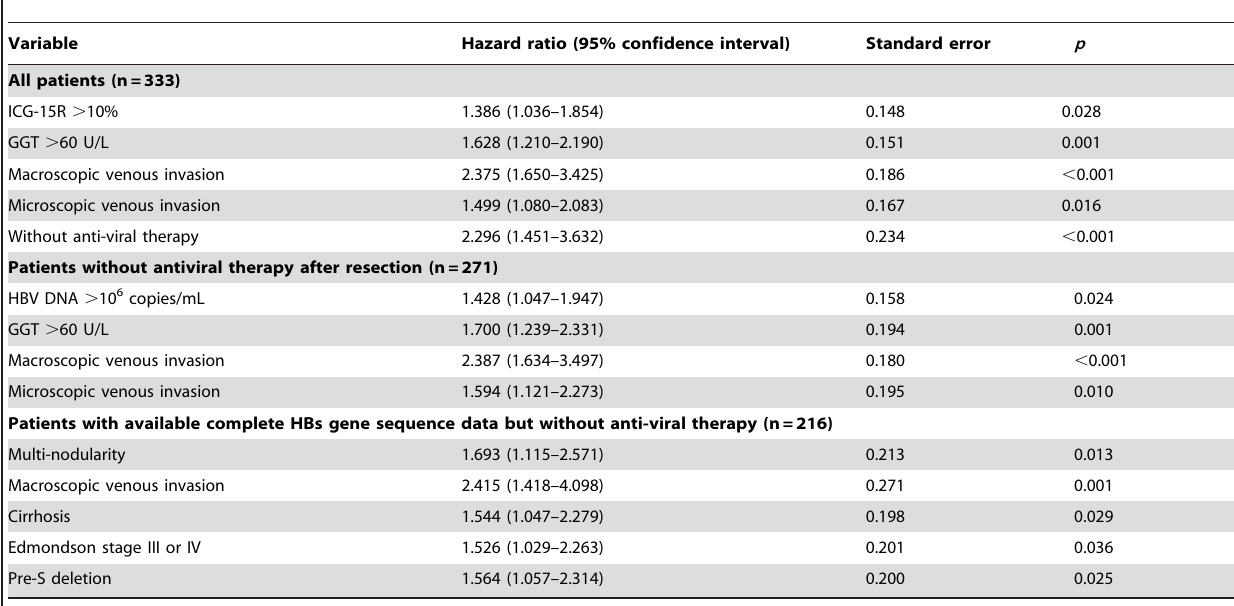
Table 2. Multivariate analysis of factors associated with recurrence after resection for HCC.